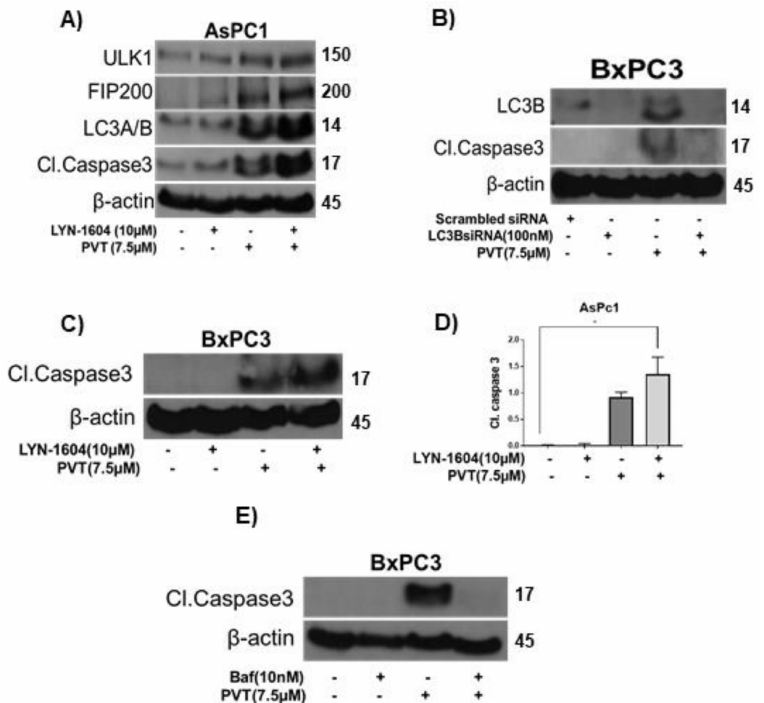
Figure 8. Modulating autophagy enhances or inhibits the apoptotic effects of PVT in BxPC3 cells. Western blot analysis on AsPC1 or BxPC3 whole cell lysates pretreated with ( A , C ) 10 µ M LYN-1604 ( B ) LC3B siRNA ( E ) 10 nM bafilomycin (Baf) for 3 h and then treated with 7.5 µ M PVT for 24 h. ( D ) Quantitated blots from Figure 8C. * p ≤